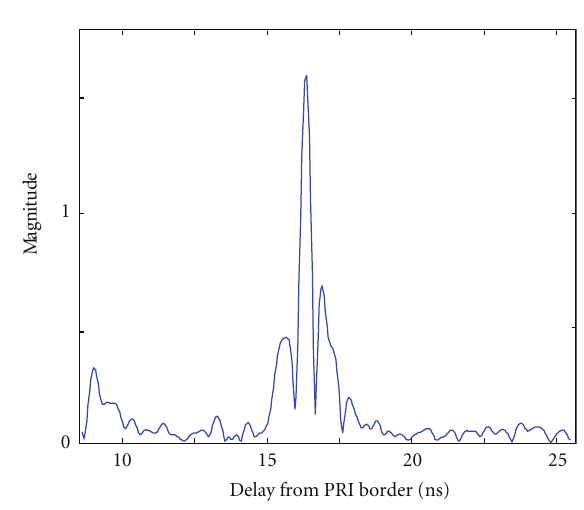
Figure 4: Pulse-compressed output signals from broadside in anechoic chamber experiments.